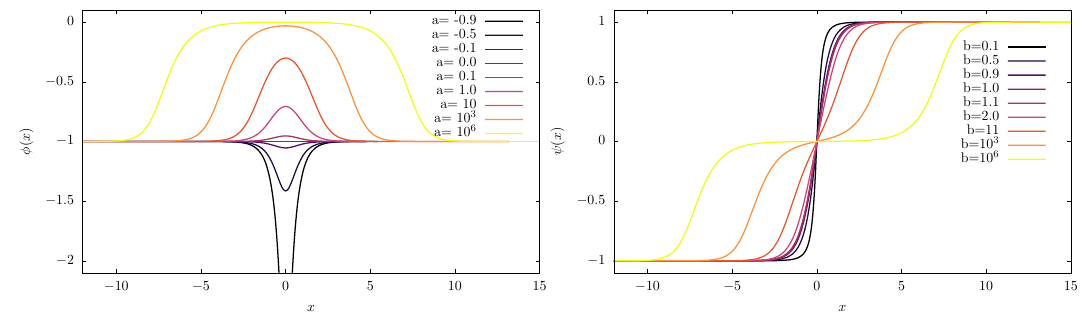
Figure 5 . 2-cycle solutions (cid:30) (left) and (right) for various values of a and b